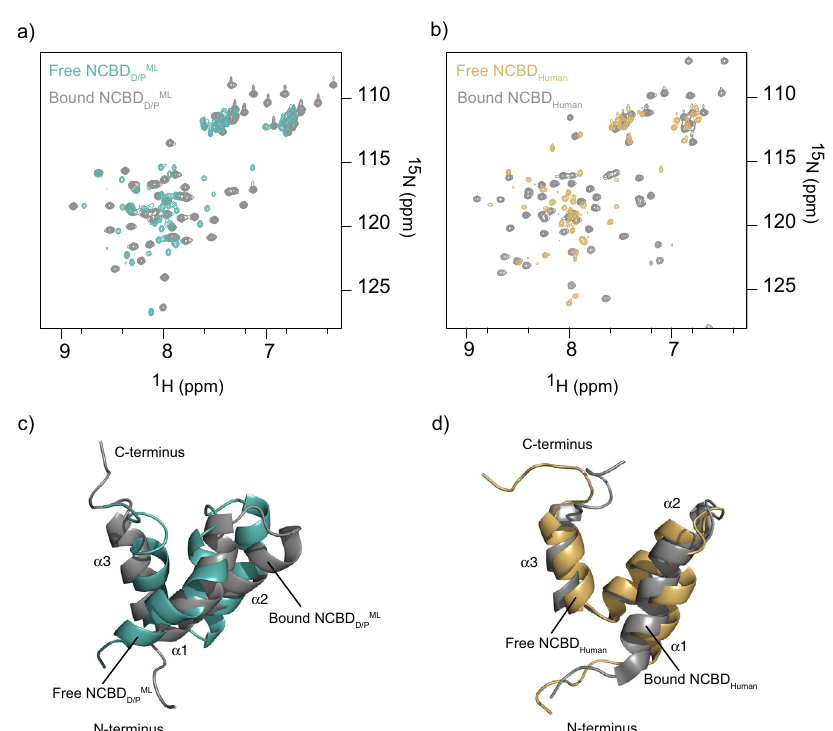
Fig. 2 Comparison of the ligand-free and bound ancestral NCBD D/P ML and extant NCBD Human . The ligand-bound conformations (PDB codes 6ES5 and 6ES7) 13 and the structure of free human NCBD (PDB code: 2KKJ) 8 were previously determined. a Overlay of the 1 H- 15 N HSQC spectra of free NCBD D/P ML at pH 2.4 (teal) and CID 1R ML -bound NCBD D/P ML at pH 6.8 (gray). b Overlay of the 1 H- 15 N HSQC spectra of free NCBD Human at pH 6.5 (gold) and CID Human -bound NCBD Human (gray) at pH 6.8. c Structural alignment of free NCBD D/P ML (teal, 7OSR, pH 2.4) and CID 1R ML -bound NCBD D/P ML (gray, 6ES5, pH 6.8). d Structural alignment of free NCBD Human (gold, 2KKJ, pH 6.5) and CID Human -bound NCBD Human (gray, 6ES7, pH